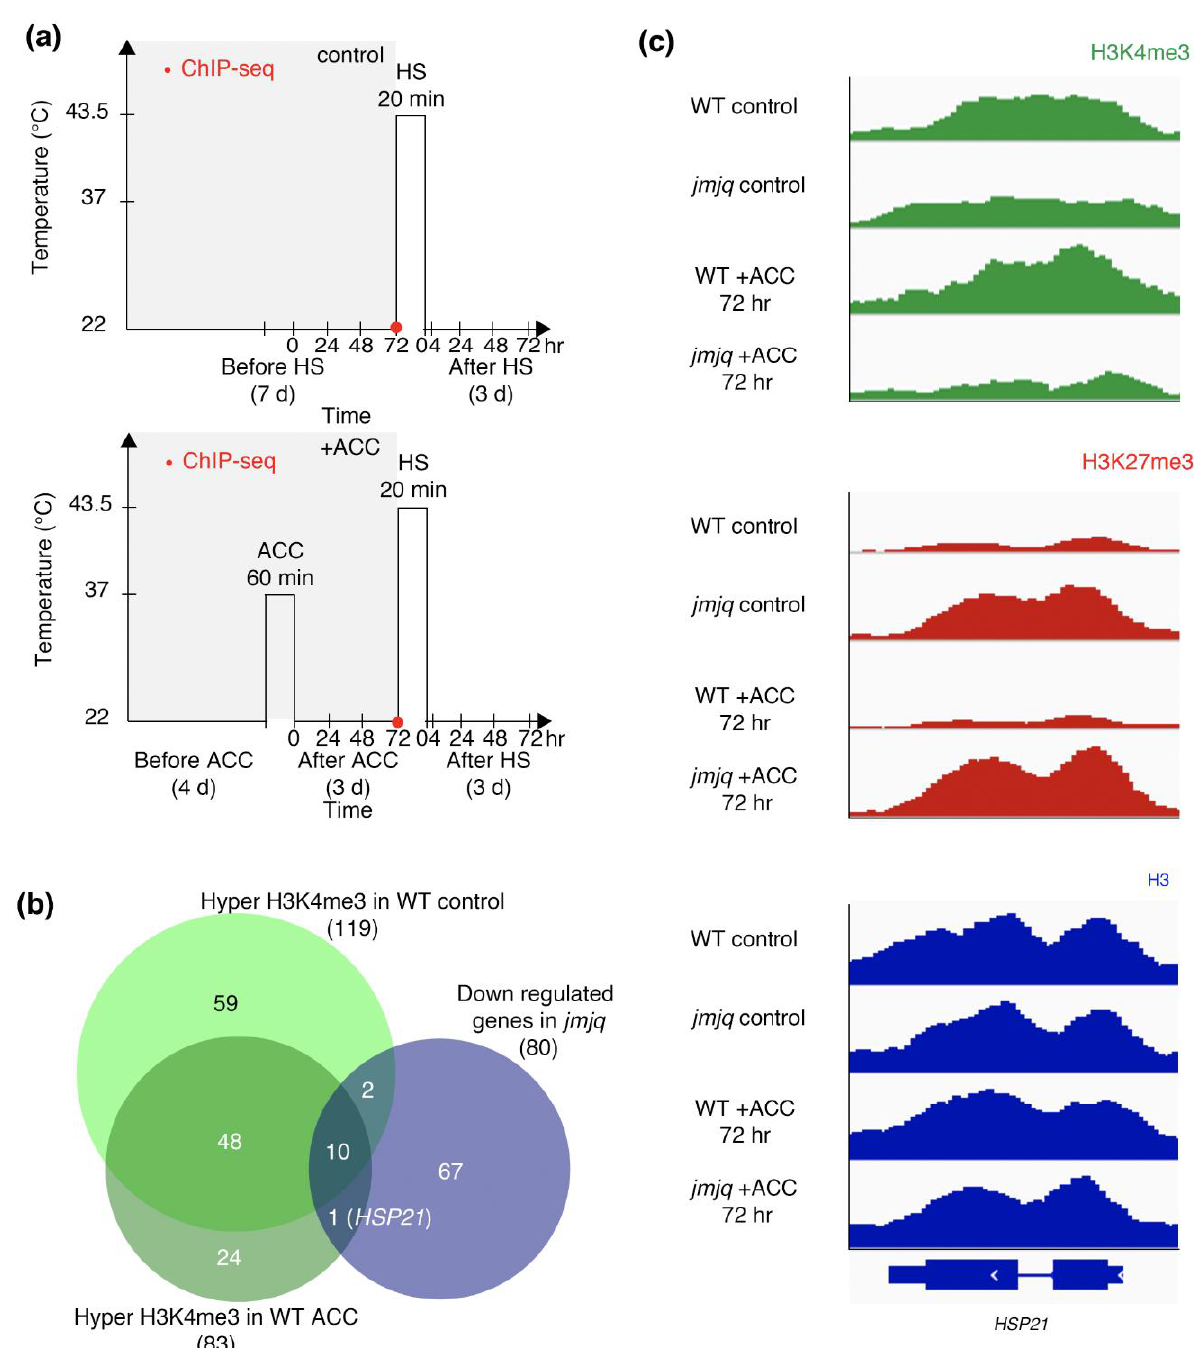
Figure 1. Jumonji demethylases are required for proper H3K4me3 accumulation in response to acclimation (ACC). ( a ) Schematic representation of the temperature conditions used. Timing of ChIP-seq is denoted by red dots. Above, basal thermotolerance condition; below, heat stress memory condition. ( b ) Venn diagrams showing the overlap between the genes downregulated in jmjq mutants and the genes with elevated H3K4me3 in the wild type (WT) with and without acclimation compared to the equivalent jmjq mutants ( p = 2.3 × 10 − 17 for elevated H3K4me3). ( c ) H3K4me3, H3K27me3, and H3 peaks at the regulatory regions of the HSP21 gene in the wild type and jmjq mutants without and with